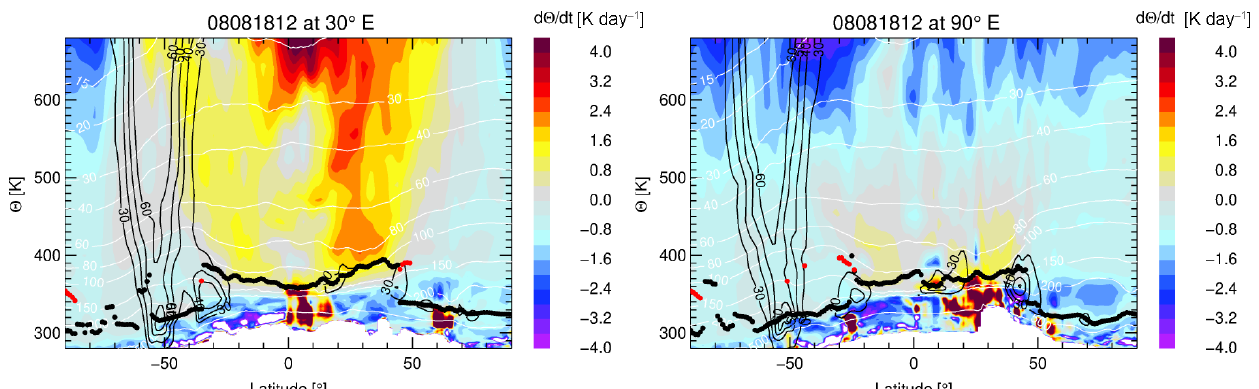
Figure 11. Latitude–theta cross section of d (cid:50)/ d t showing the radiative heating above the Asian monsoon anticyclone for the western (30 ◦ E) and eastern mode (90 ◦ E) of the anticyclone on 18 August 2008. The thermal tropopause (primary in black dots and secondary in red dots) and absolute horizontal winds (black lines for 30, 40, 50, and 60ms − 1 ) are shown. The pressure levels are marked by thin white lines.